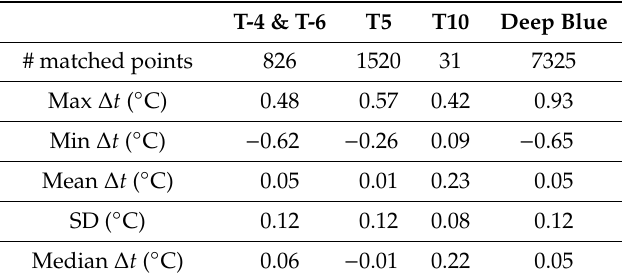
Table 4. ∆ t (XBT-Argo) for each XBT type involved. Depth: 100 m-bottom ( ± 7